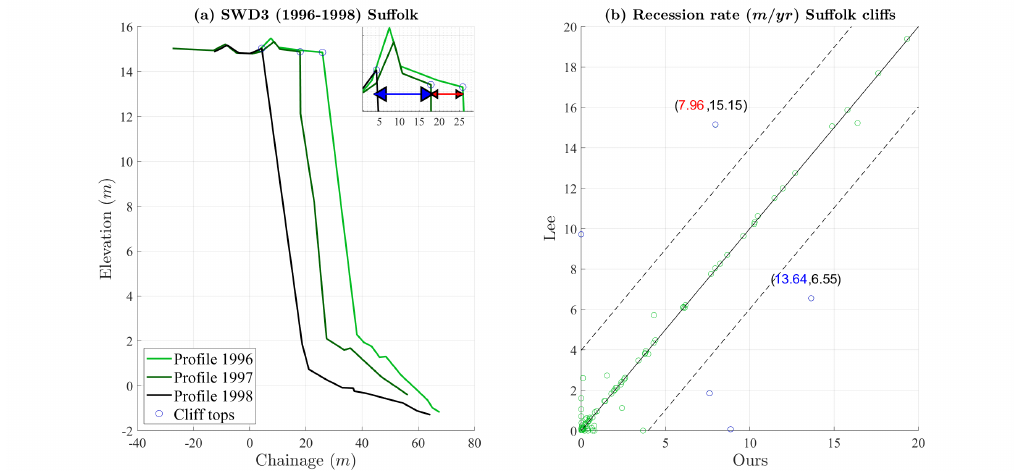
Figure A2. Examples of one potential error made in Lee’s work [3]. ( a ) Profile plots from SWD3 years 1996–1998 where the cliff tops that we have used are indicated. A zoom in the cliff top area is shown where the top recession can be estimated at first glance. ( b ) Cliff top recession rate scatter plot for Suffolk where the two corresponding outliers with our (red and blue) and Lee’s values (black) are